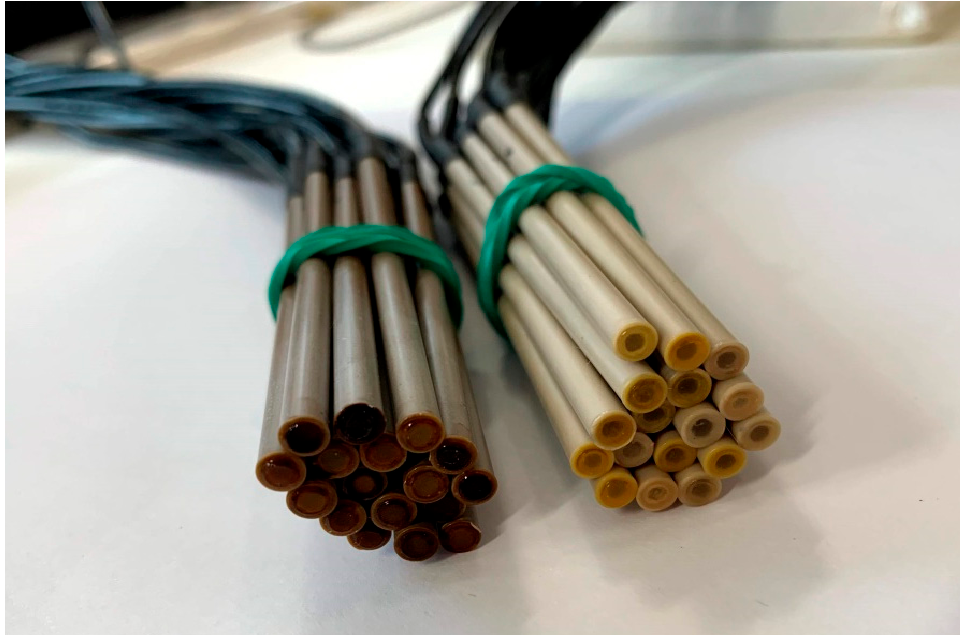
Figure 3. The visual appearance of the studied sensor arrays after exposure to gamma radiation ( left ) and without exposure ( right ).